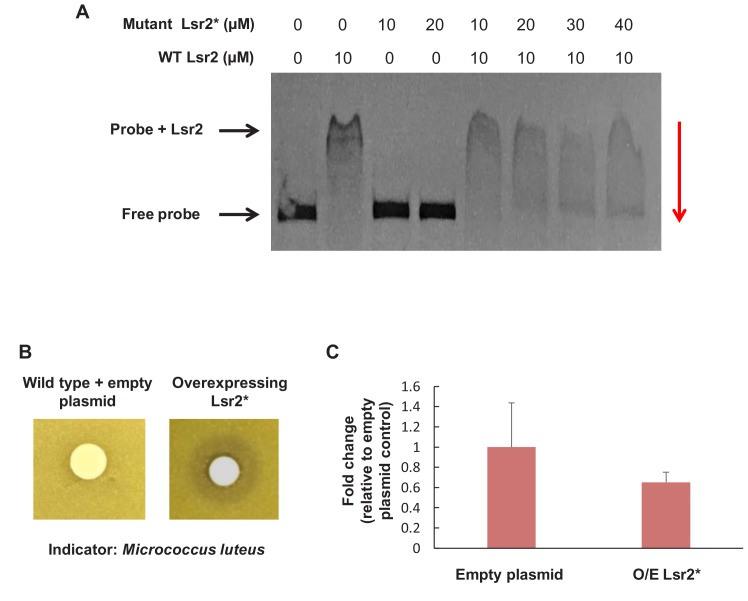
Dominant negative Lsr2 variant (Lsr2*) inhibits DNA binding by wild type Lsr2 and promotes antibiotic production in S. venezuelae.(A) Electrophoretic mobility shift assay illustrating DNA binding by wild type Lsr2, no DNA binding by the R82A mutant allele (mutant Lsr2*), and effective inhibition of Lsr2 binding by the mutant variant, based on the increasing abundance of ‘free probe’ as mutant concentrations rise. Probe: 1.5 kb region corresponding to the Lsr2 binding site in the chloramphenicol biosynthetic cluster. Reactions were separated on a 1% agarose gel stained with ethidium bromide. (B) Bioactivity of S. venezuelae extracts against Micrococcus luteus. Wild type S. venezuelae carrying either a control (empty) plasmid (left), or one overexpressing the mutant 9R82A) Lsr2 variant (right; Lsr2*) were cultured for 18 hr prior to extraction in methanol and reconstitution in DMSO. Extracts were applied to Whatman filter discs, and cultures were grown overnight. (C) Quantitative PCR analysis of Lsr2-3xFLAG-binding to the validated target site sven_0926, following ChIP, for a strain carrying an empty plasmid (control) or overexpressing Lsr2* (O/E Lsr2*). Overexpressing Lsr2* led to a 40% drop in binding by Lsr2. ChIP experiments were conducted in duplicate, and qPCR was done for each replicate in technical triplicate.